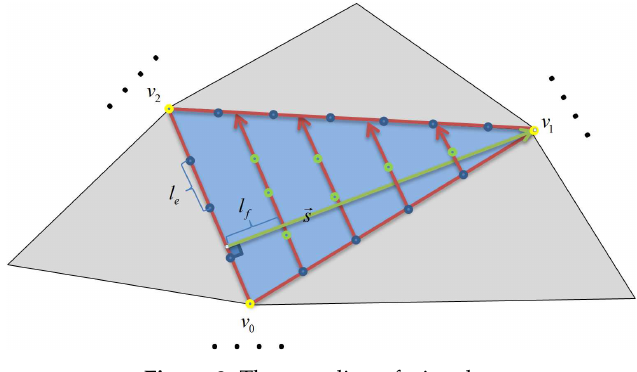
Figure 3. The sampling of